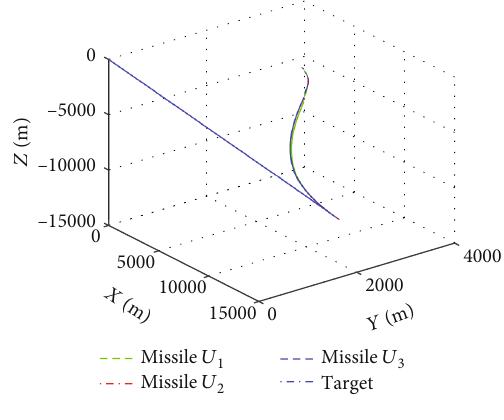
Figure 3: Relative trajectories.